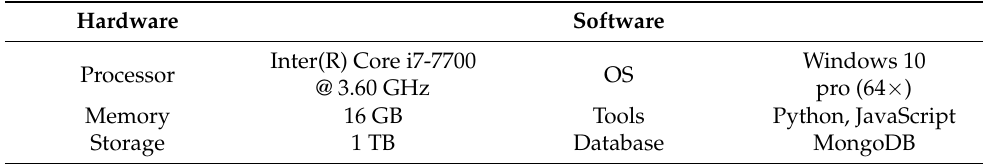
Table 4. Software and hardware environment.